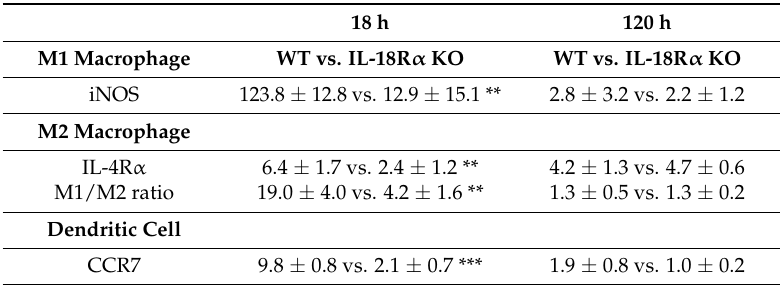
Table 3. M1/M2 macrophages phenotype by real-time